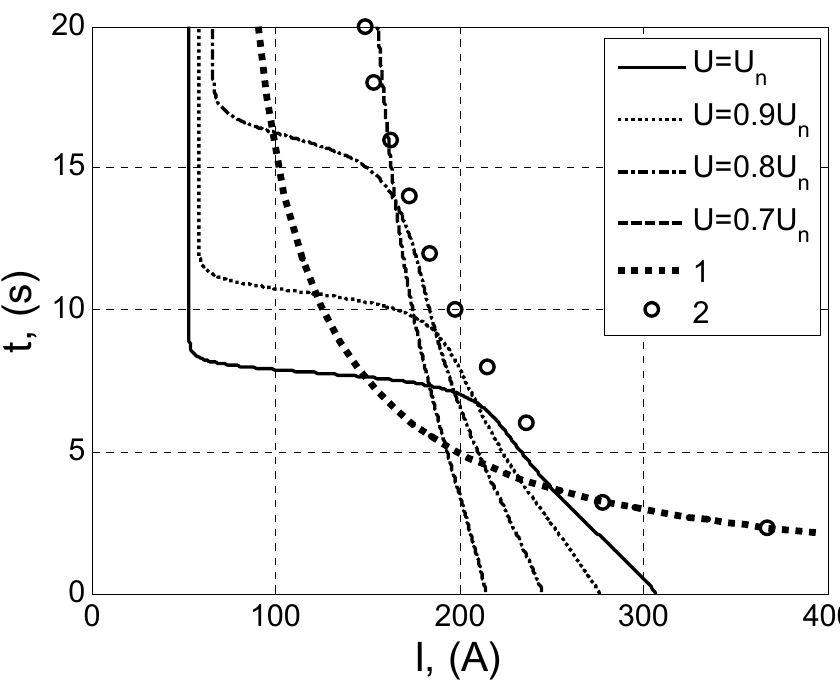
Figure 8. Data points selected for the determination of a new time-current characteristic on the background of simulated current RMS waveforms and Very Inverse characteristics. 1—Very Inverse characteristics, 2—selected data points.